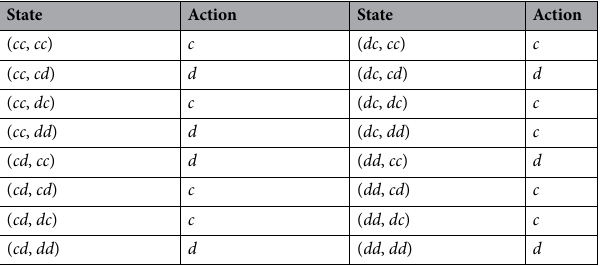
Table 1. List of actions in TFT-ATFT 25 . Two players Alice and Bob are involved in the iterated PD game, and we assume that Alice is playing TFT-ATFT. Let A t and B t denote Alice’s and Bob’s actions at time t , respectively. In this table, each state means ( A t − 2 A t − 1 , B t − 2 B t − 1 ) , and the corresponding action means A t